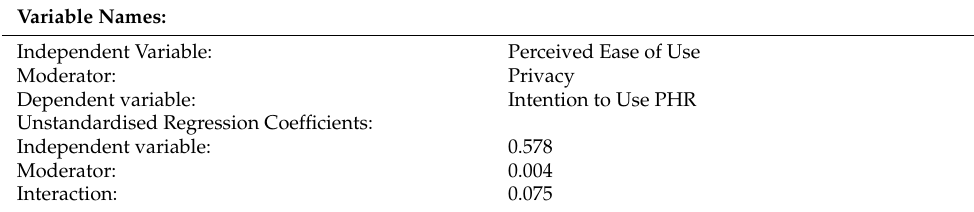
Figure 3. Usability Positively Moderated the Relationship between Perceived Ease of Use and In- tention to Use PHR.